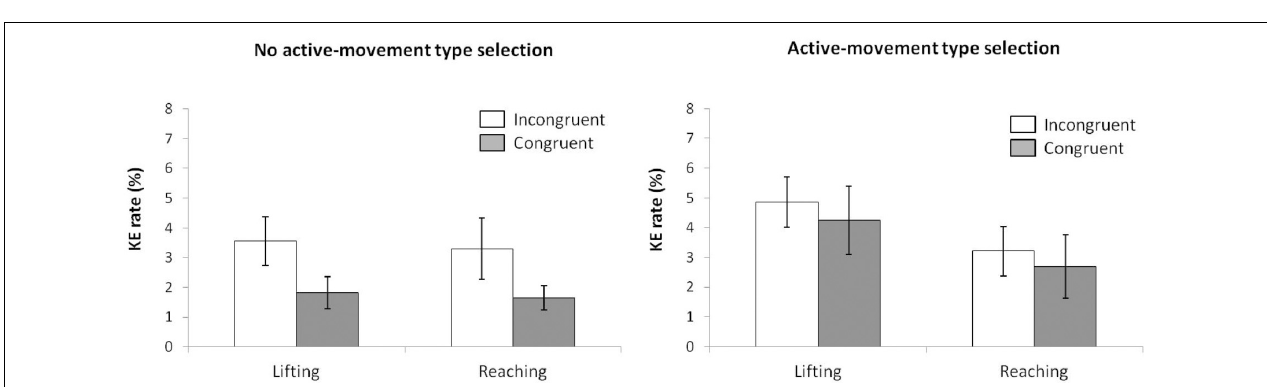
FIGURE 8 | Interactions of movement × congruence within the no active-movement type selection condition (Left) and active-movement type selection (Right) , with respect to rate of kinematic errors in Experiment 3. Error bars represent the standard error of the mean.